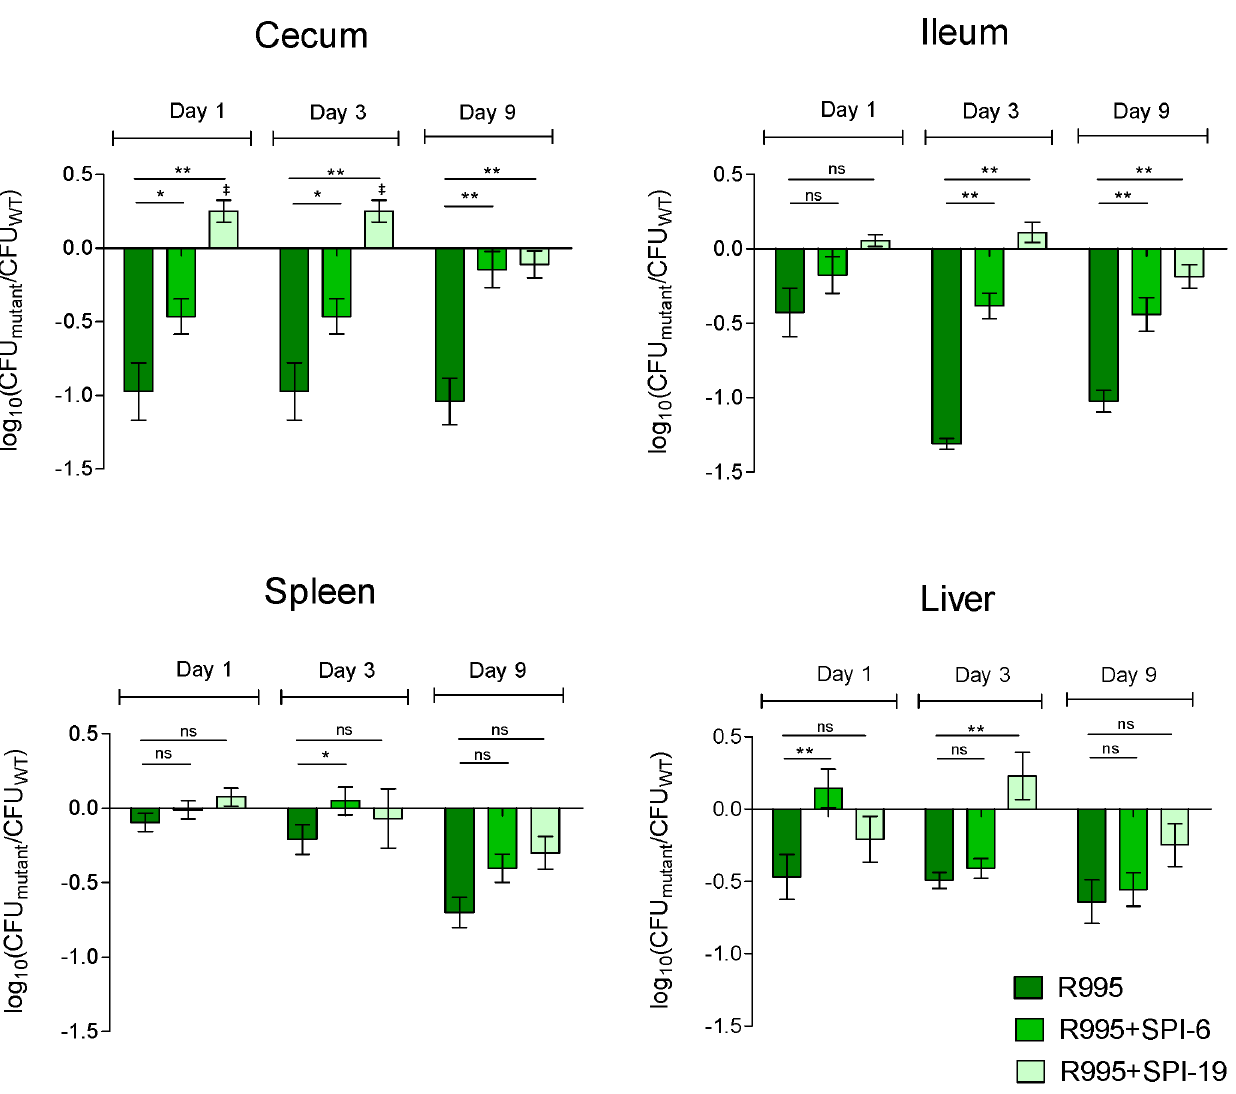
Figure 4. Invivo competition between the D T6SS SPI-6 mutants complemented intrans with T6SS SPI-6 or T6SS SPI-19 and the wild type S . Typhimurium 14028 s. Fifteen four-day-old White Leghorn chicks were orally infected with 10 9 CFU of a mixture at a 1:1 ratio of strains WT/ R995, D T6SS SPI-6 /R995 + SPI-6 and D T6SS SPI-6 /R995 + SPI-19. At 1, 3 and 9 days post-infection groups of five chicks were sacrificed and the organs were excised, homogenized, and serially diluted for determination of bacterial loads. Bars represent the geometric mean of the log converted ratio of the mutant CFU to the wild type CFU normalized to the equivalent ratio in the inoculum. Error bars denote standard error. Statistical significance was determined using a two-tailed Student’s t test, and asterisks indicate statistically significant differences between normalized output ratios (* P , 0.05). ` Indicate statistically significant differences between normalized output ratios and the equivalent ratio in the inoculum ( ` P , 0.05). doi:10.1371/journal.pone.0063917.g004 The complemented strain (MTM35R6) was tested in a competition experiment against the D T6SS SPI-6 mutant and the wild type, each bearing the empty vector (MTM35/R995 and WT/R995, respectively) and colonization was determined at days 1, 3, and 9 post infection. As shown in Figure 4 , transfer of the T6SS SPI-6 gene cluster to the D T6SS SPI-6 mutant restored its ability to colonize the cecum and the ileum at all time points. On the other hand, in the spleen and liver, the results were not conclusive due to a very low and heterogeneous colonization of these deeper tissues by S . Typhimurium harbouring the R995 plasmid (data not shown). Nevertheless, complementation of the defective phenotype of the D T6SS SPI-6 mutant in the gastrointes- tinal tract supports the contribution of T6SS SPI-6 in chicken colonization.